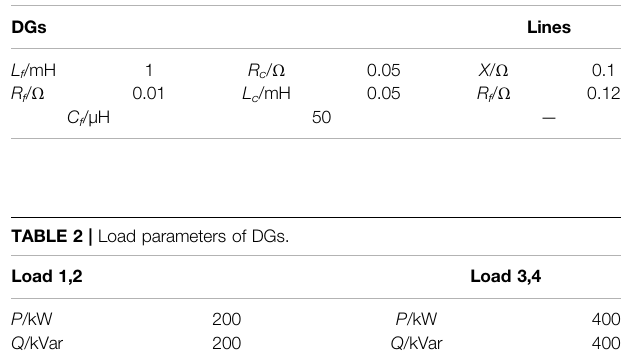
TABLE 1 | Structural parameters of DGs.